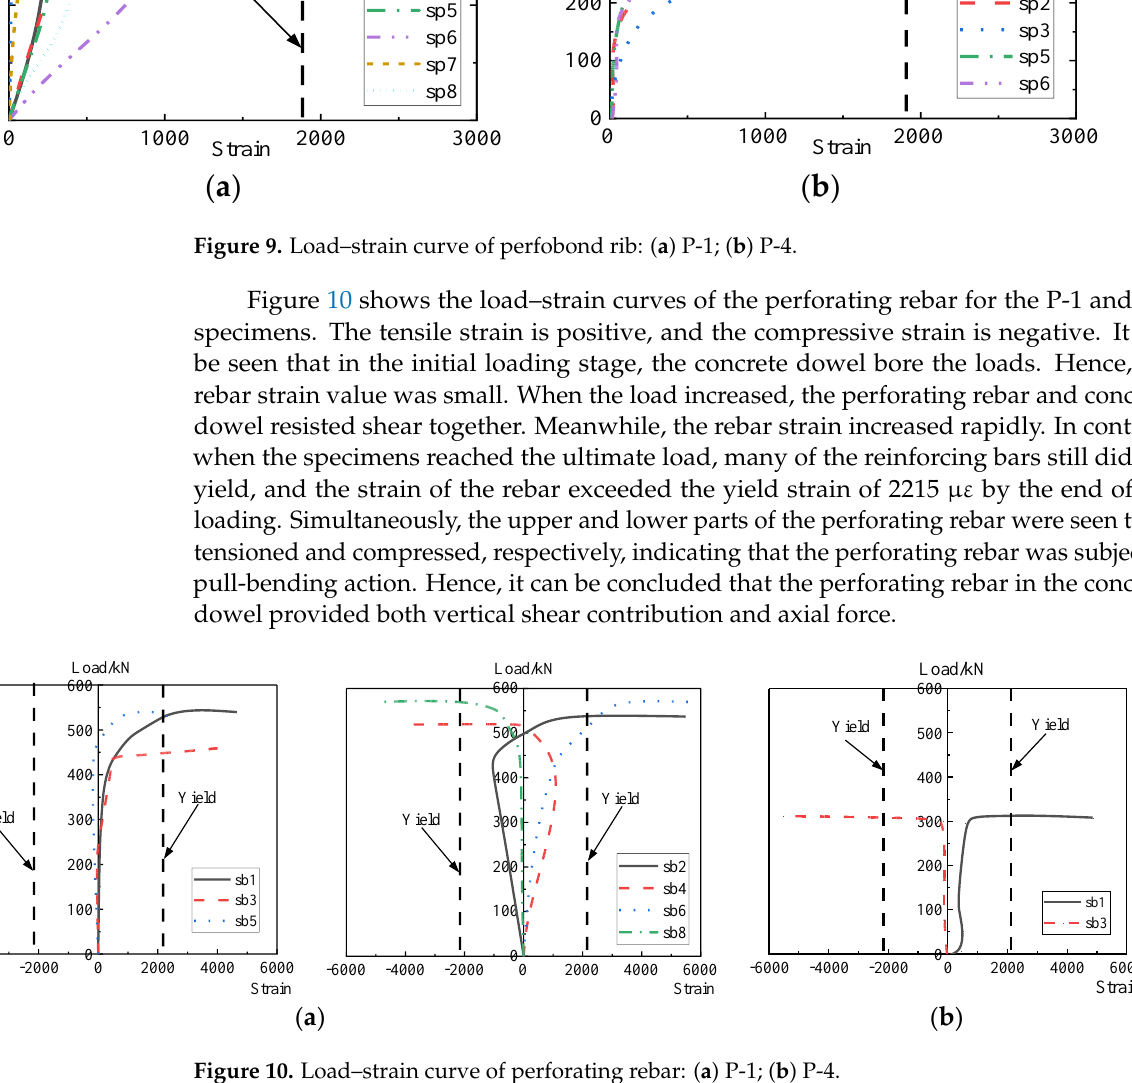
Figure 10. Load–strain curve of perforating rebar: ( a ) P-1; ( b ) P-4.